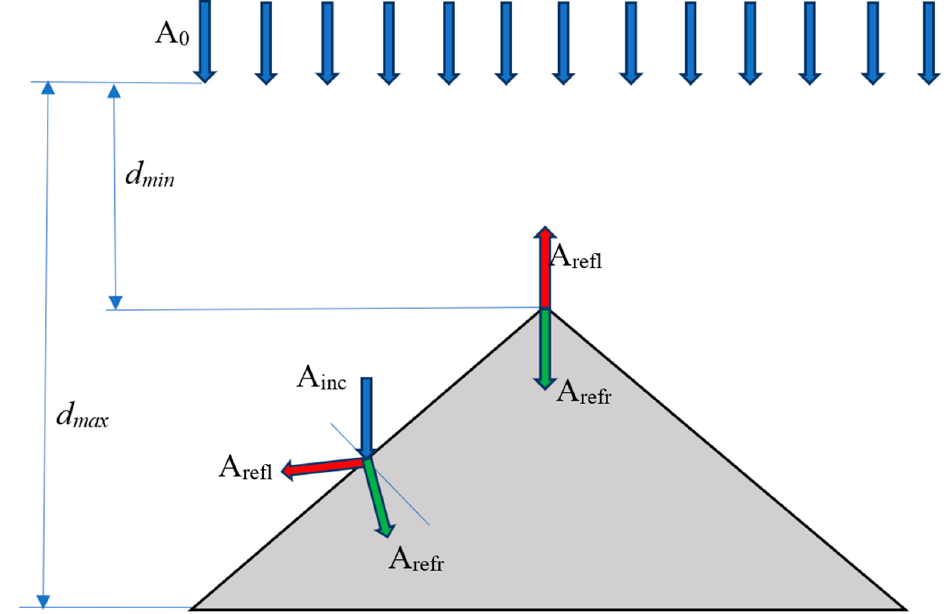
Figure 7. Changes in the parameters of the impact of the primary impulse of force when falling on a triangular object.